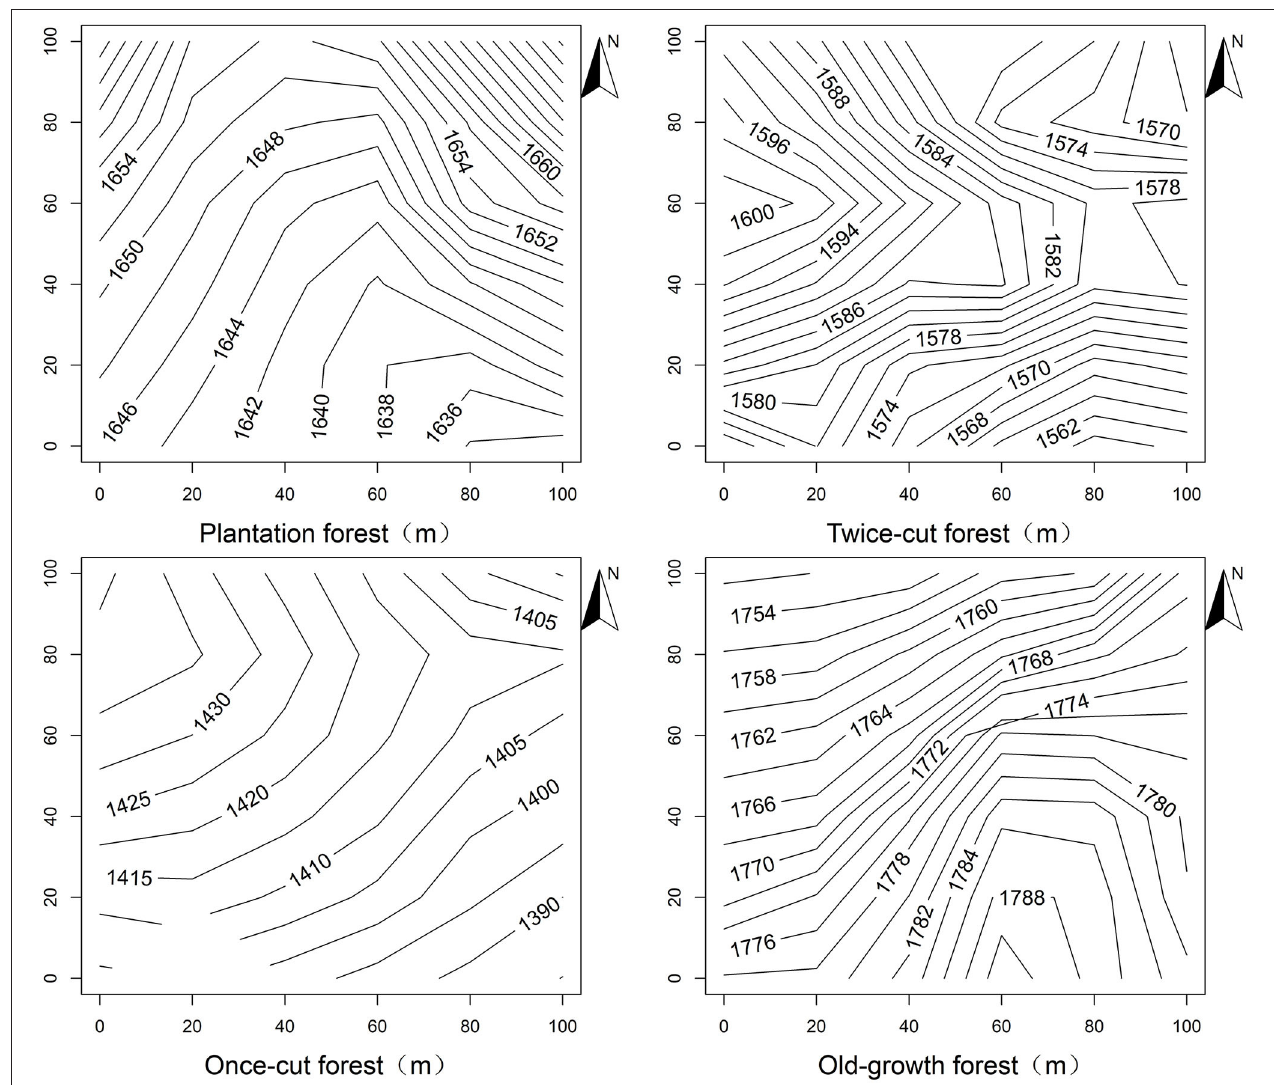
FIGURE 1 | Contour topography map of Baiyunshan